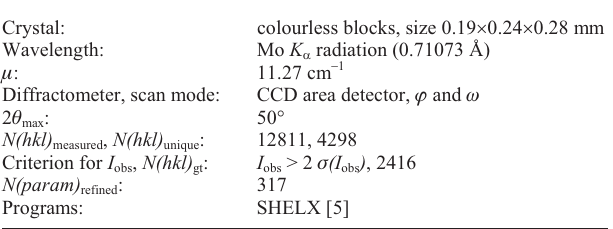
Table 1. Data collection and handling.